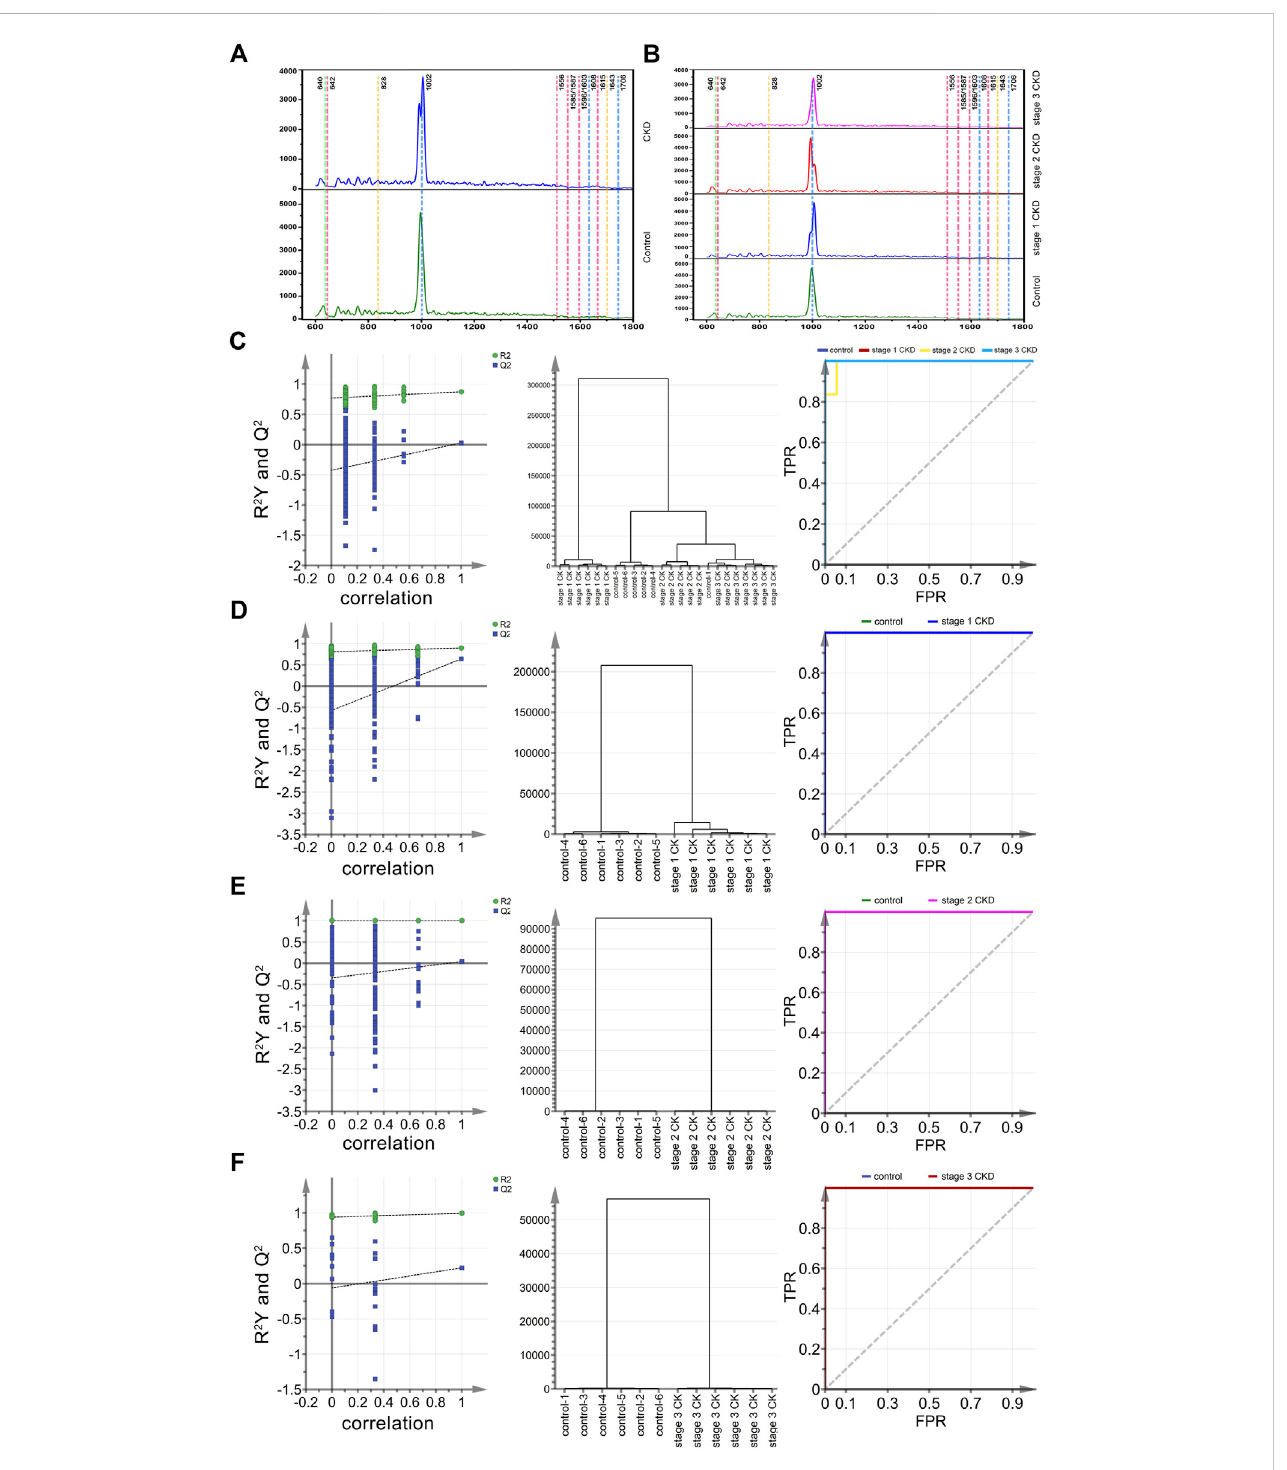
FIGURE 2 Mean spectral and multiparametric analysis of different CKD stages and control groups combined with HUA. (A) (from bottom to top) the average urine spectra of the control group (green solid line) and CKD subgroups (blue solid line). (B) (from bottom to top) the average urine spectra of the control group (green solid line), stage 1 CKD group (blue solid line), stage 2 CKD group (red solid line) and stage 3 CKD group (pink solid line), with the latter three combined withHUA; (C) Thearrangement,clustering,andROCcurvesofthecontrolgroup,discriminatedbyOPLSandtheCKDsubgroupcombinedwithHUA. (D) The arrangement, clustering and ROC diagram of OPLS discriminated control group and stage 1 CKD group combined with HUA; (E) The arrangement, clustering and ROC diagram of OPLS discriminated control group and stage 2 CKD group combined with HUA; (F) The arrangement, clustering and ROC diagram of OPLS discriminated control group and stage 3 CKD group combined with